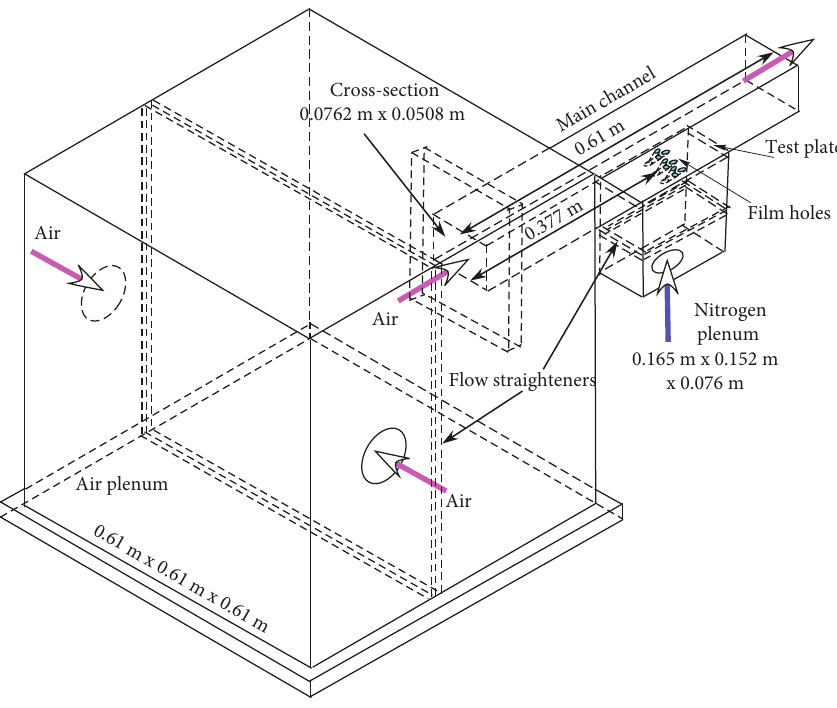
Figure 2: Schematic of the test